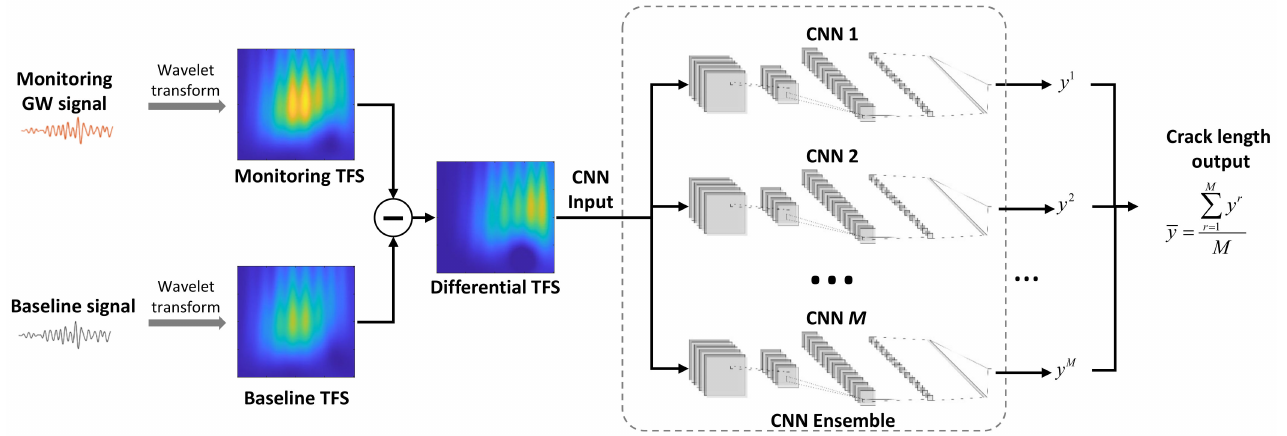
Figure 3. Implementation of the GW–CNN ensemble-based fatigue crack